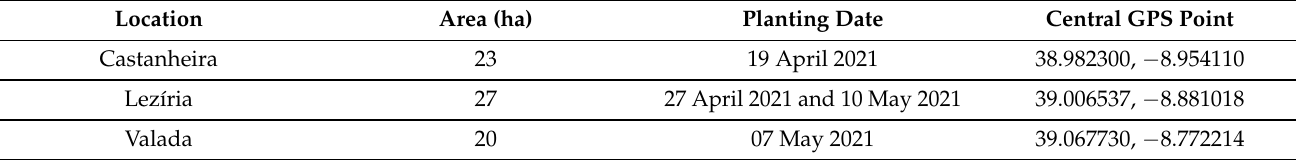
Table 1. Information on the tomato crop fields where data were acquired.